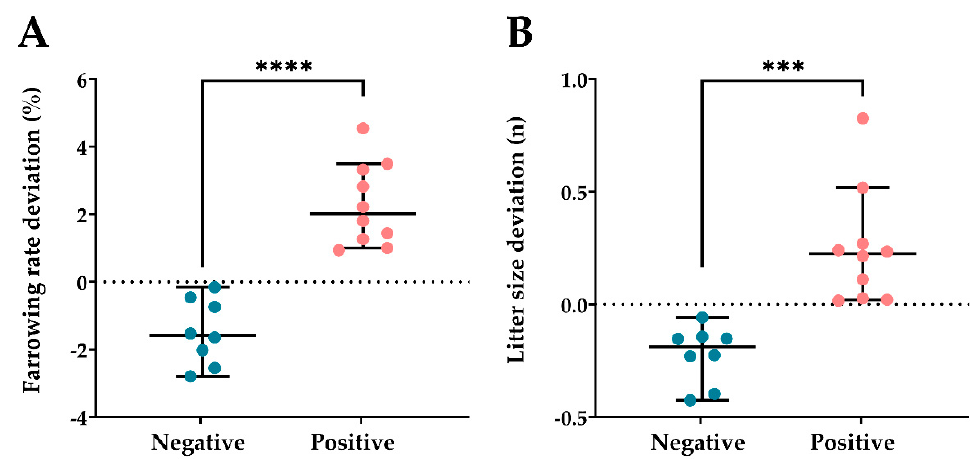
Figure 3. Distribution by hierarchical cluster analysis ( p < 0.001) of the 18 boars used in artificial insemination programs into two groups for having ( A ) negative (between − 2.79 and − 0.16; n = 8) or positive (between +0.94 and +4.54; n = 10) farrowing rate deviations; and ( B ) negative (between − 0.43 and − 0.05; n = 8) or positive (between +0.01 and +0.83; n = 10) litter size deviations. The line indicates the median, the whiskers extend to the 5th and 95th percentiles, and the dots represent the boars. **** p < 0.0001; *** p < 0.001.